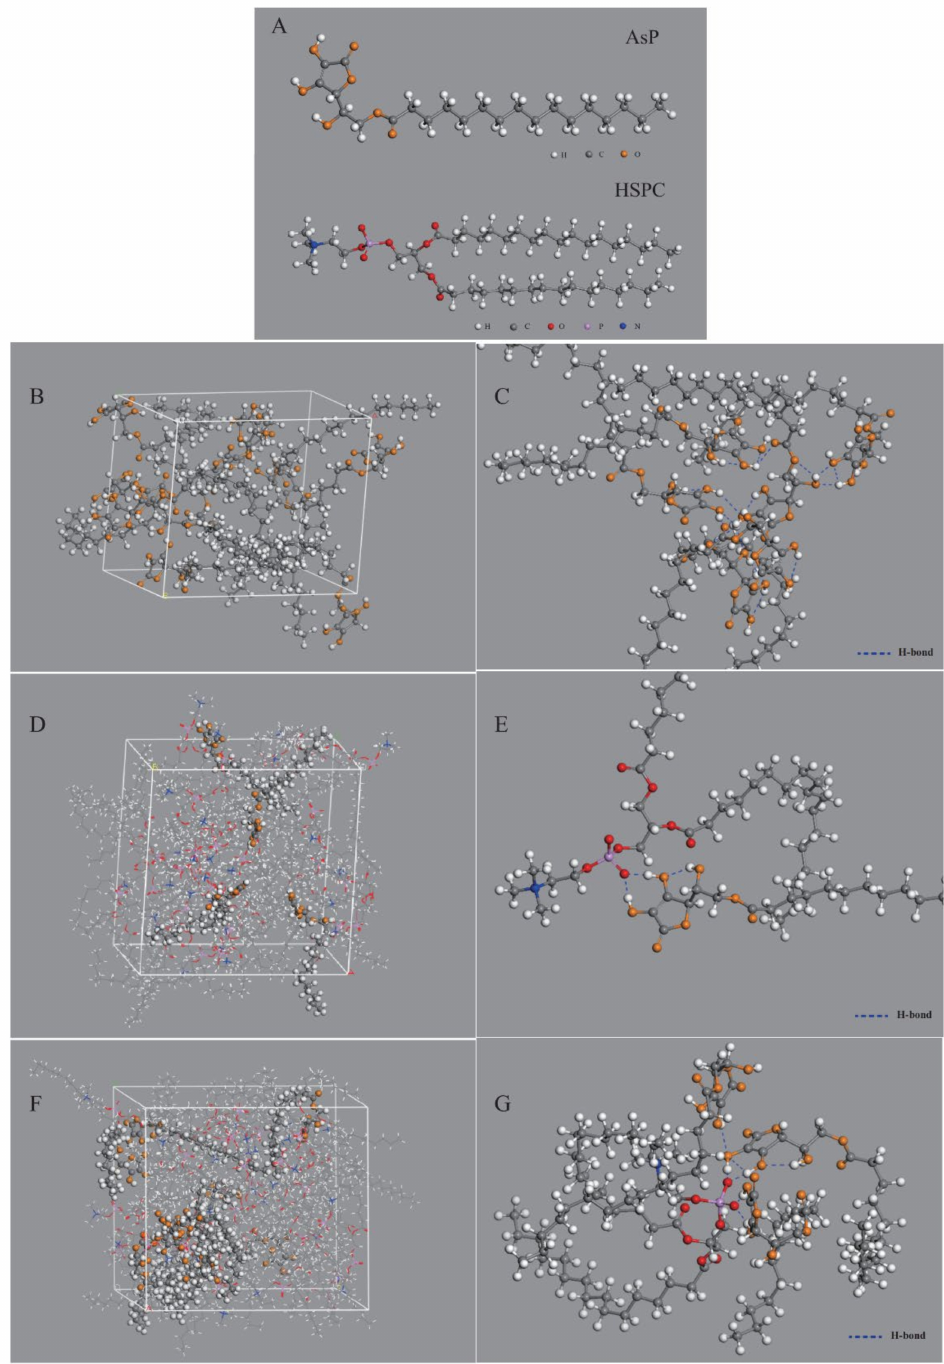
Figure 8. Computer models of molecular interaction between AsP and PC in AsP–PC composites by molecular dynamics simulation: ( A ) 3D structure of AsP and HSPC molecules; ( B ) the simulated single-component AsP model; ( C ) molecular interactions in the single component AsP model (the hy- drogen bonds are given in blue dash lines); ( D ) the simulated AsP–PC model with 8 wt% AsP/HSPC (HSPC molecules are displayed in concise patterns by lines to distinguish it from AsP); ( E ) molecular interactions between AsP and HSPC in the AsP–PC model with 8 wt% AsP/HSPC; ( F ) the simulated AsP–PC model with 20 wt% AsP/HSPC (HSPC molecules are displayed in concise patterns by lines to distinguish it from AsP); ( G ) molecular interactions between AsP and HSPC in the AsP–PC model with 20 wt%